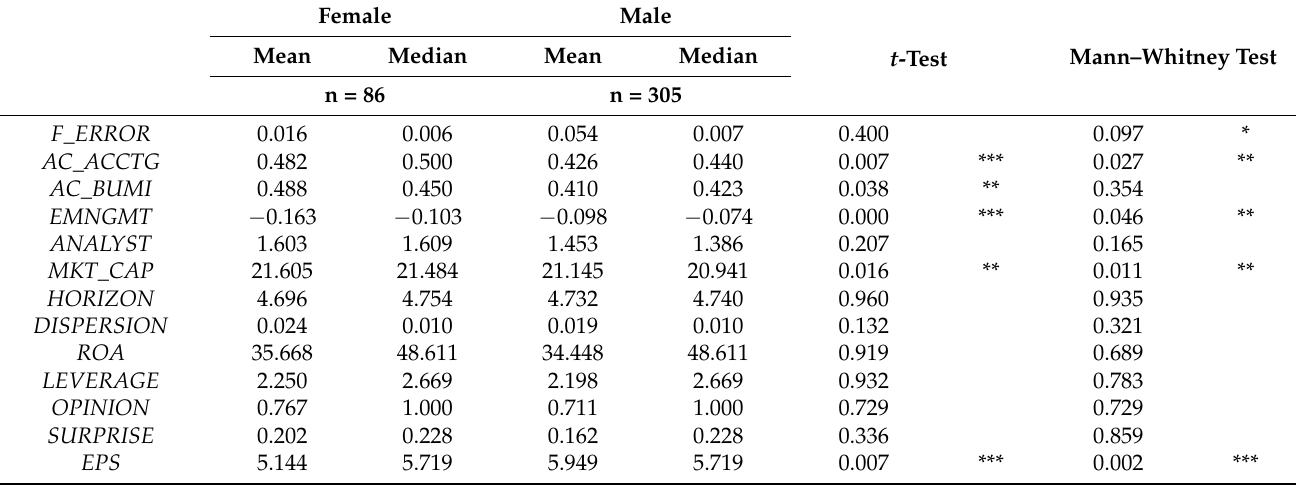
Table 5. Univariate Analysis between Male and Female Audit